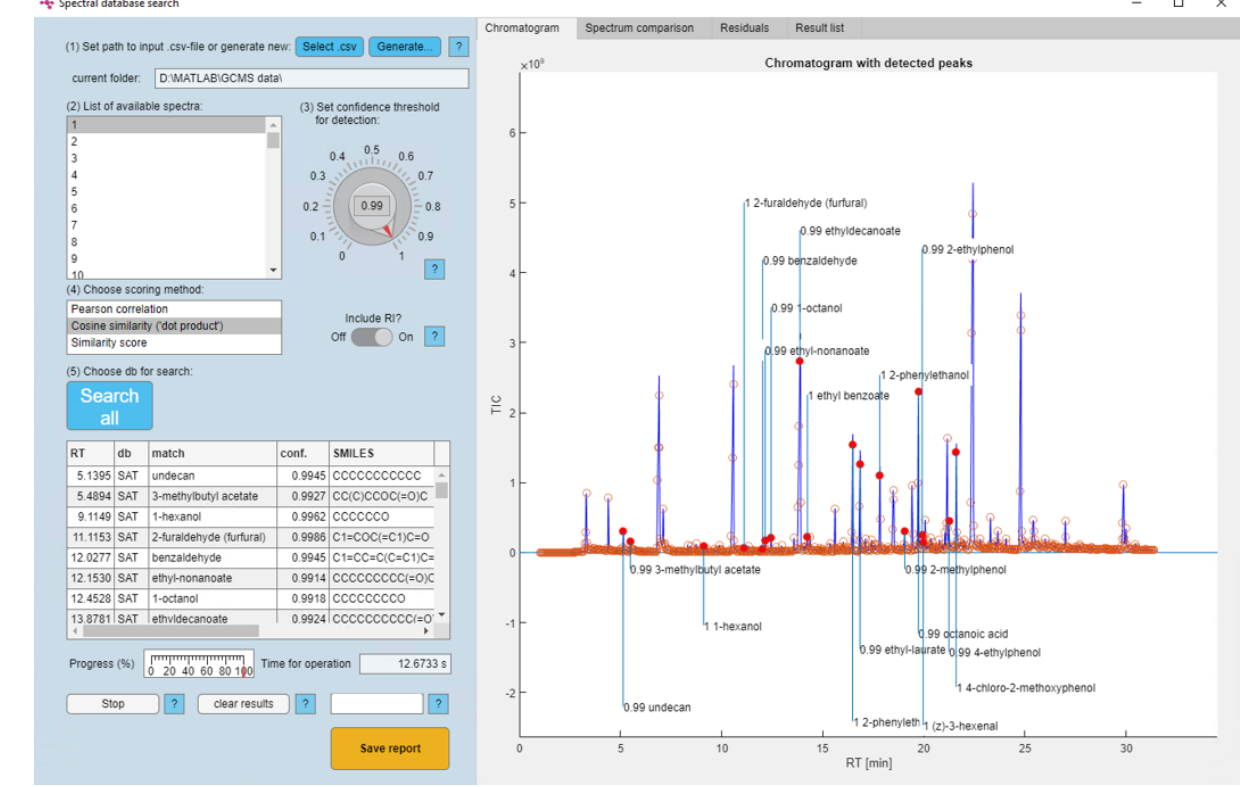
Figure 4. Full view of the graphical user interface with an exemplary chromatogram and compounds detected with high confidence values (note: the confidence threshold was set to 0.99 for ease of